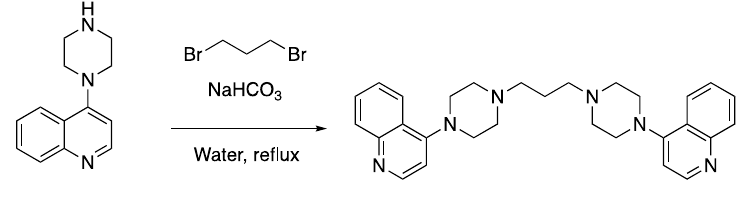
Figure 3. Synthesis of compound 1.